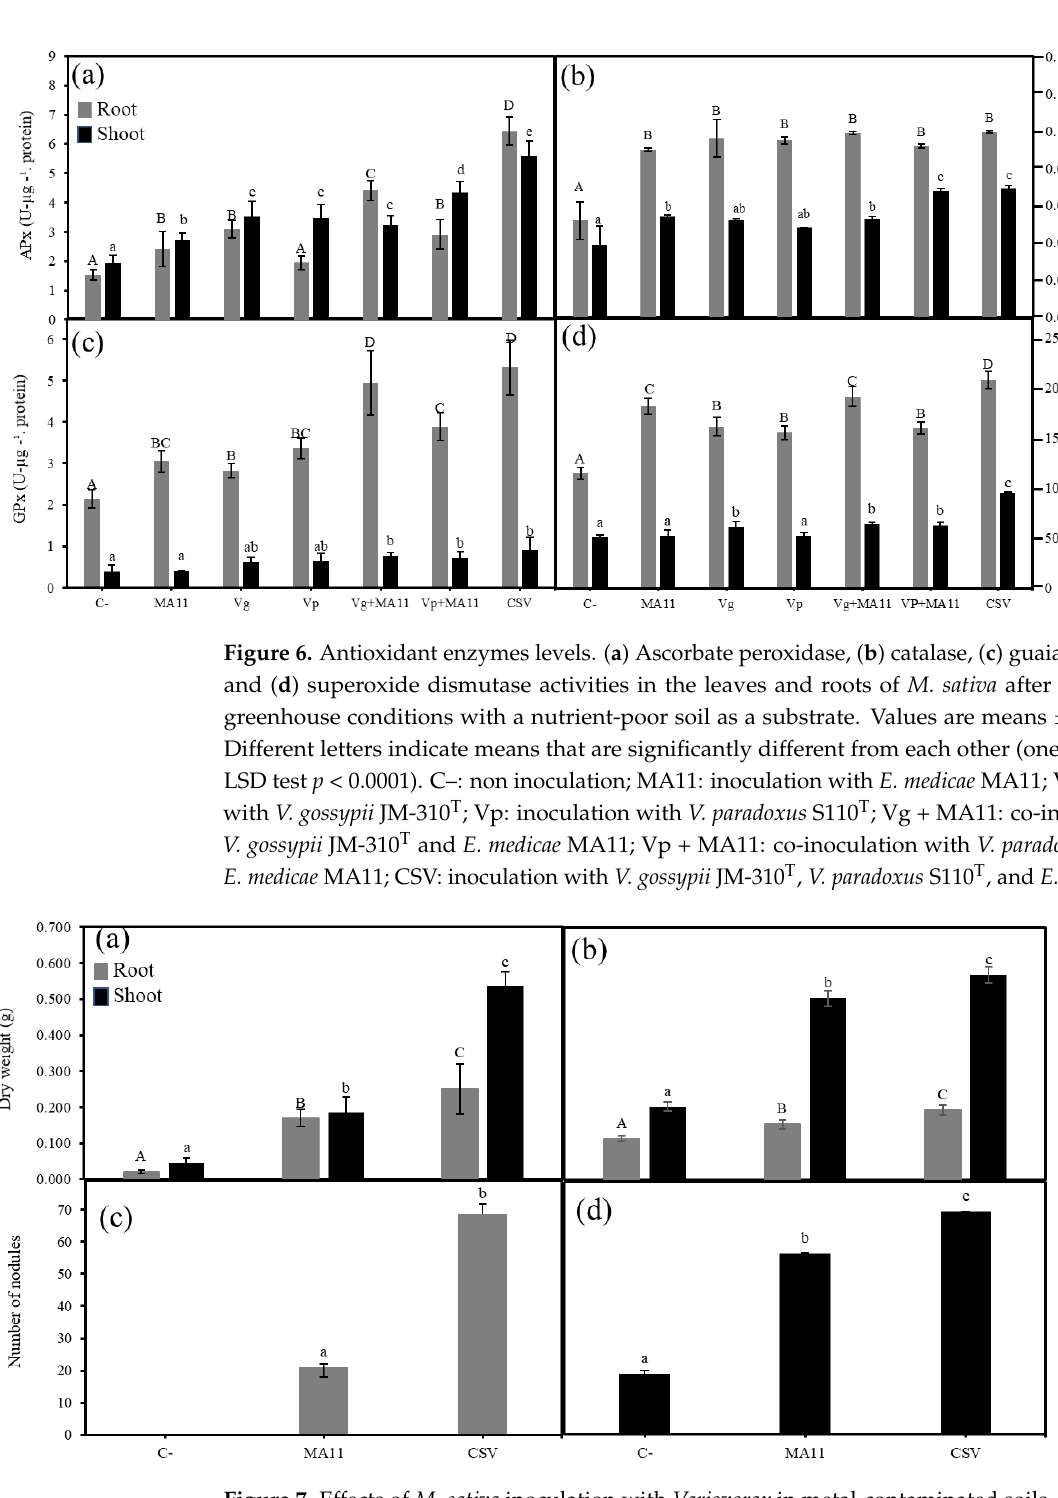
Figure 7. Effects of M. sativa inoculation with Variovorax in metal-contaminated soils. ( a ) Dry weight, ( b ) length, ( c ) number of nodules, and ( d ) nitrogen content in shoots of M. sativa plants after 60 days in pots with soils polluted with metals as substrates under greenhouse conditions. Values are means ± S.D. ( n = 16). Different letters indicate means that are significantly different from each other (one-way ANOVA; LSD test, p < 0.0001). C–: non inoculation; MA11: inoculation with E. medicae MA11; CSV: inoculation with V. gossypii JM-310 T , V. paradoxus S110 T , and E. medicae MA11.